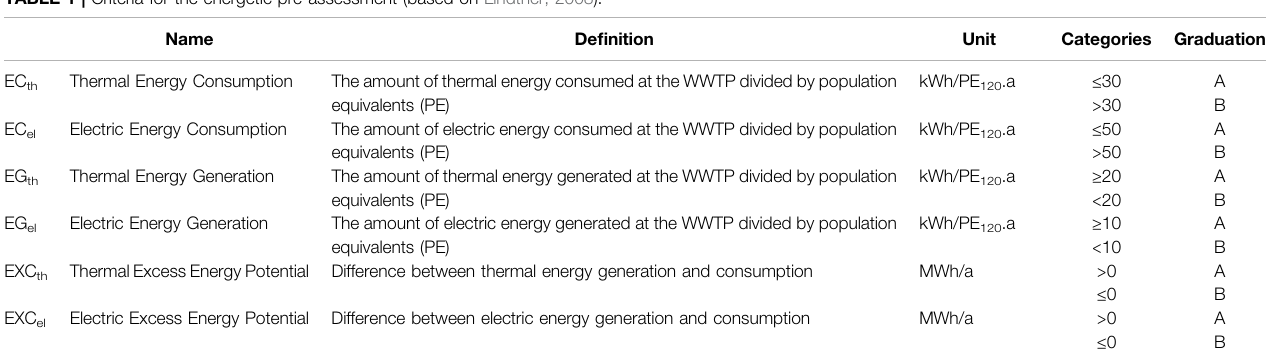
TABLE 1 | Criteria for the energetic pre-assessment (based on Lindtner,